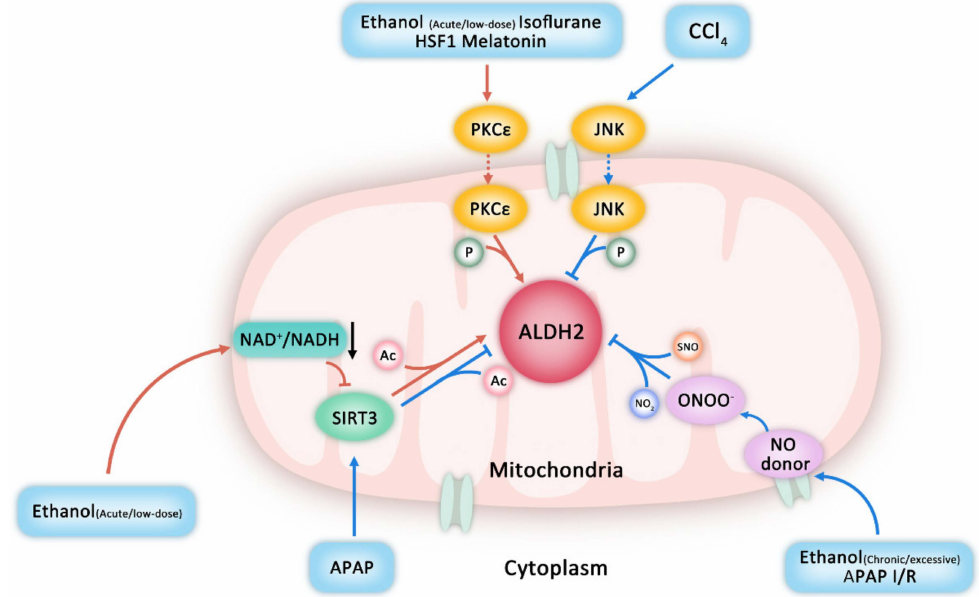
Figure 4. Effect of protein post-translational modifications (PTMs) on ALDH activity. Ethanol (acute/low-dose), isoflurane, heat shock factor 1 (HSF1), and melatonin can lead to phosphory- lation and activation of aldehyde dehydrogenase 2 (ALDH2) by activating phosphatidylinositol protein kinase C epsilon (PKC ε ). ALDH2 can also be activated by its acetylation increased by the inactivation of sirtuin 3 (SIRT3) stimulated by ethanol (acute/low-dose). The phosphorylation of ALDH2 promoted by c-Jun NH 2 -terminal kinase (JNK) under carbon tetrachloride (CCl 4 ) exposure as well as the S-nitrosylation and tyrosine nitration of ALDH2 stimulated by ethanol (chronic or excessive abuse), acetaminophen (N-acetyl-p-aminophenol [APAP]), nitric oxide (NO) donor, and ischemia/reperfusion (I/R) injury can inhibit ALDH2 activity. P = phosphorylation; Ac = acetylation; SNO = S-nitrosylation; NO 2 =